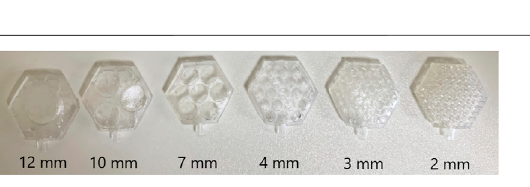
FIGURE 4 | Comparison of suction holes (from left to right): 12 mm single-point suction part, 10 mm 3-point suction part, 7 mm 7-point suction part, 4 mm 19-point suction part, 3 mm 37-point suction part, and 2 mm 91- point suction part.